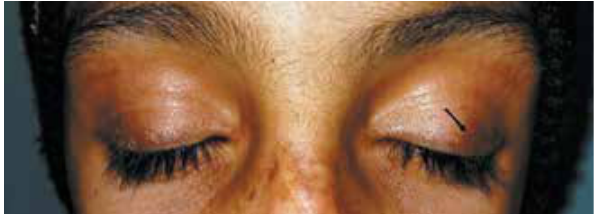
Fig 5. Symmetrical lilac patch over both upper eyelids (Heliotrope rash)